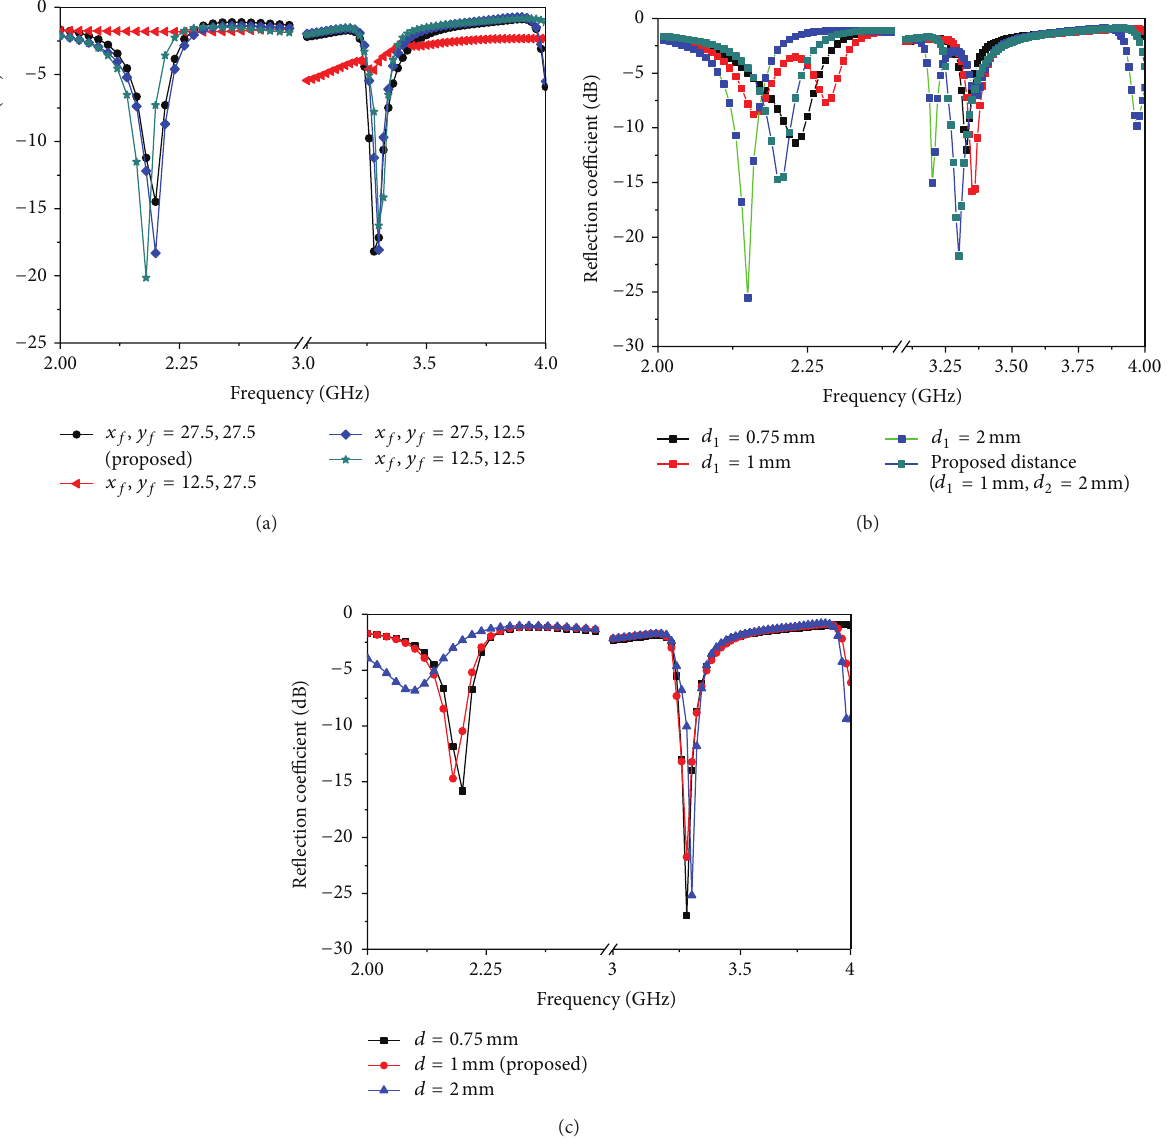
Figure 4: Reflection coefficient performance for the cross-shaped antenna for different values of (a) feed position ( 𝑥 𝑓 , 𝑦 𝑓 ) and (b) 𝑑 1 and (c) 𝑑